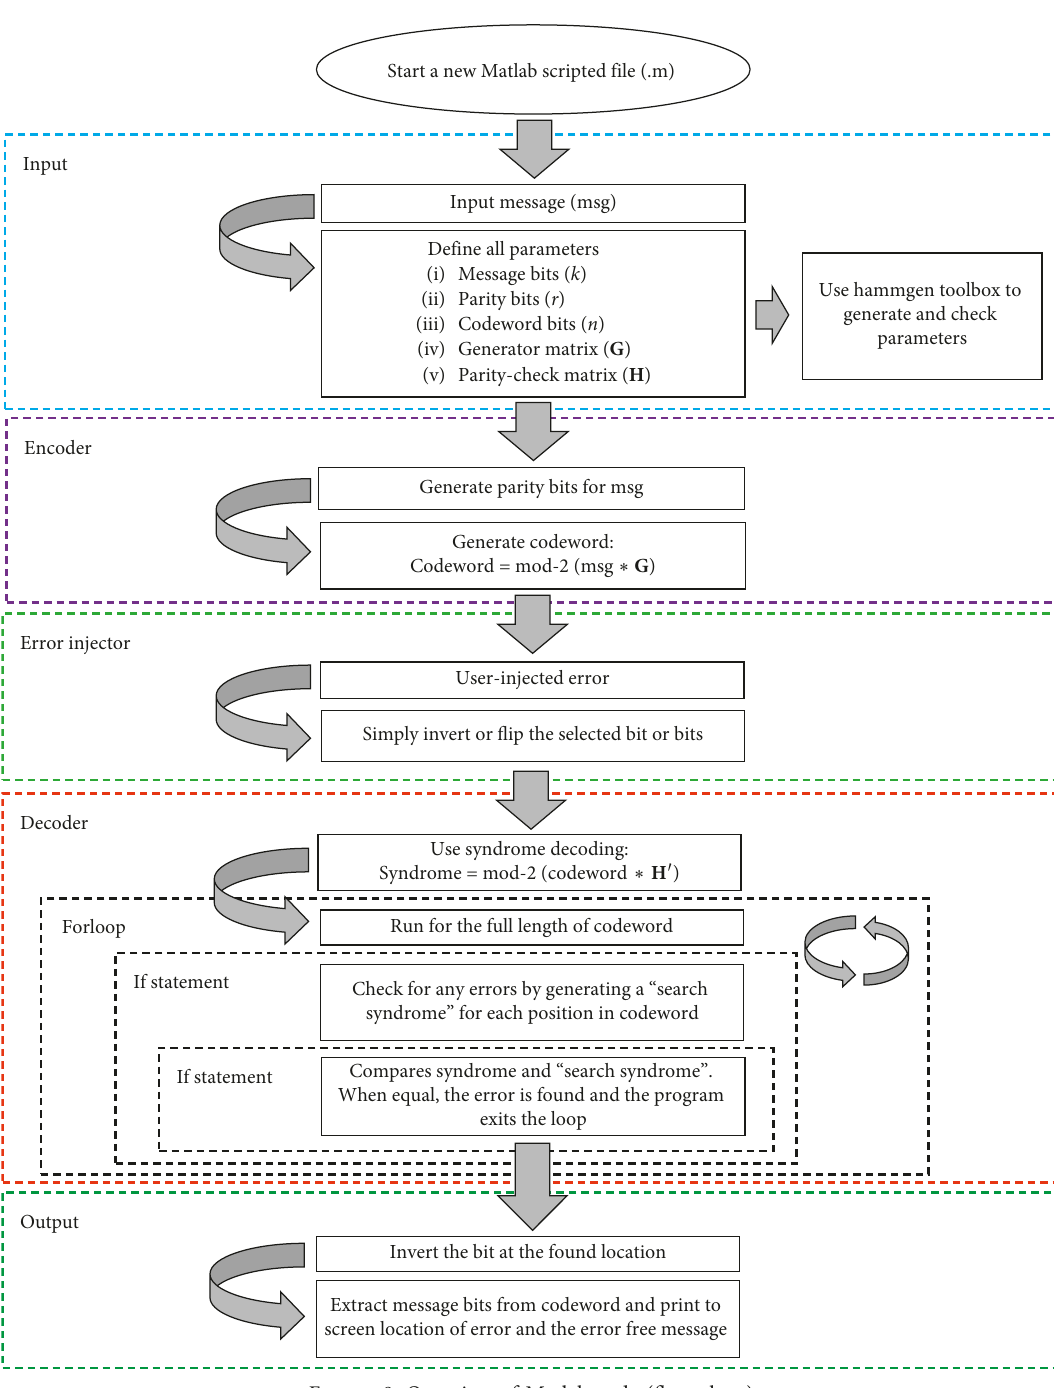
Figure 8: Overview of Matlab code (flow